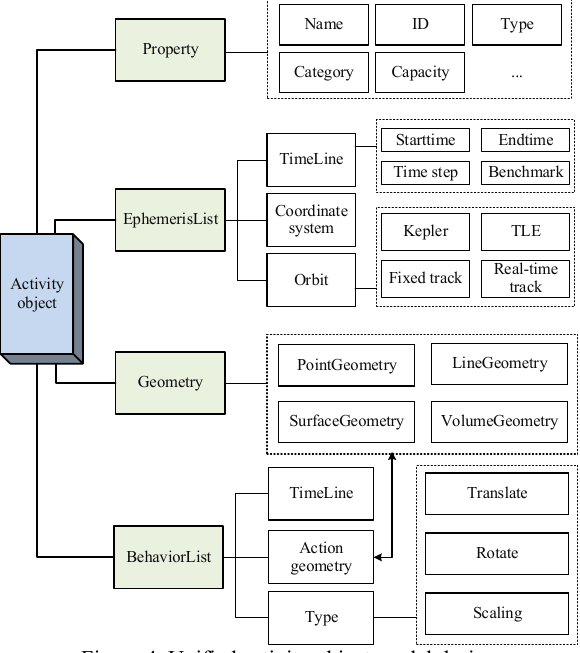
Figure 4. Unified activity object model